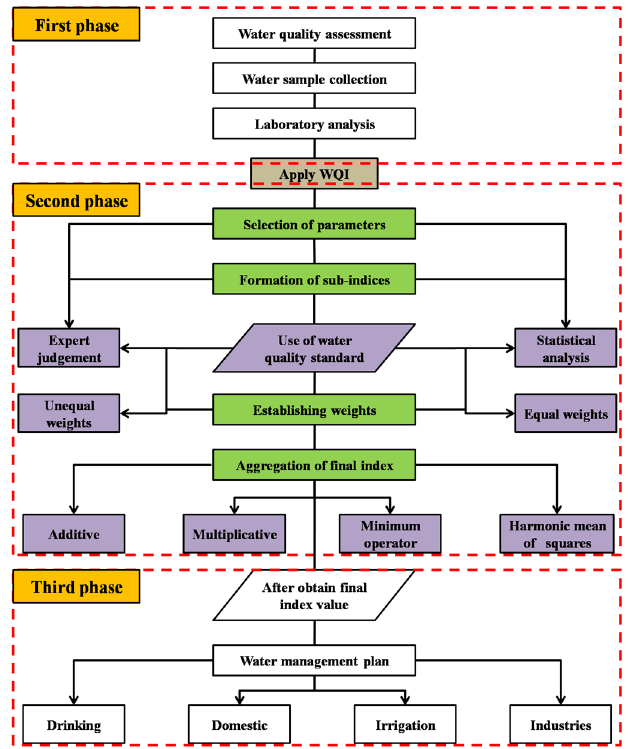
Figure 3. This show three phases for applying WQI method, in which the first phase demonstrates that the water quality assessment process. The second phase relates to the WQI process for four common steps (green color) wherein the method is applied to each step (purple color) and the third phase to the water management plan for different